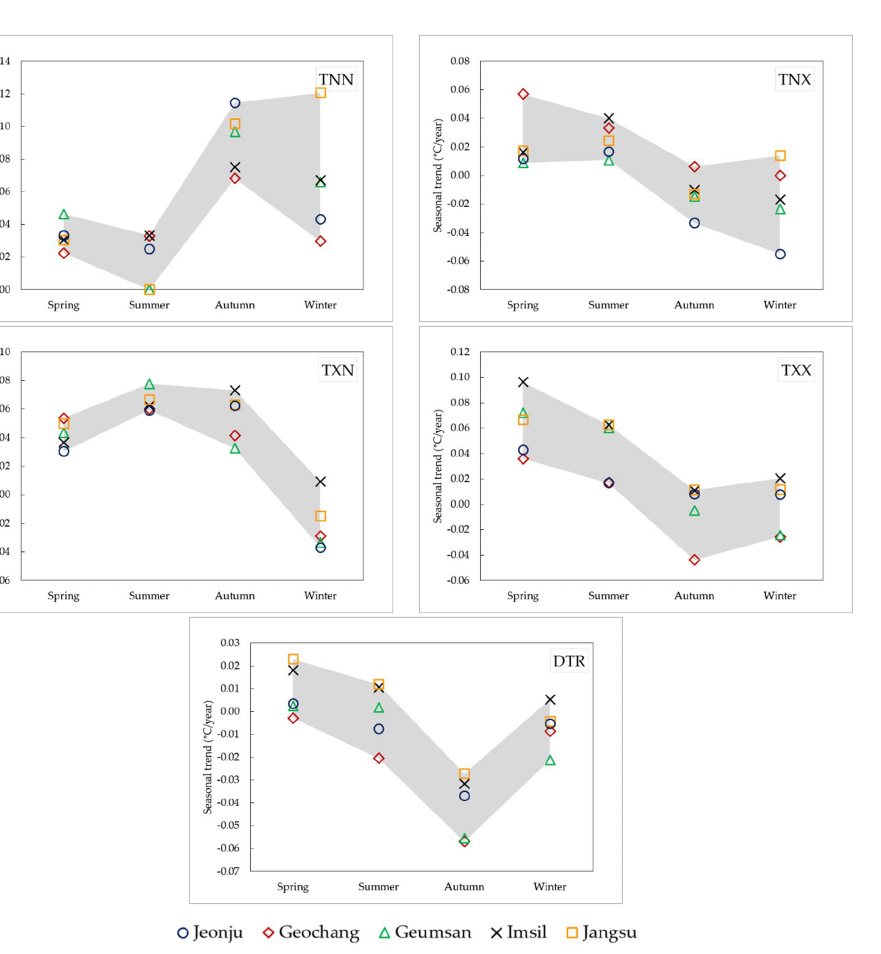
Figure 4. The seasonal trend magnitudes of all temperature intensity indices at the UGRB. For autumn season, the DTR, TNx, and TXx (TNn and TXn) indices were observed with decreasing (increasing) trends. While DTR and TNn were observed with significant decreasing (increasing) trends, other indices only showed weak seasonal trends.